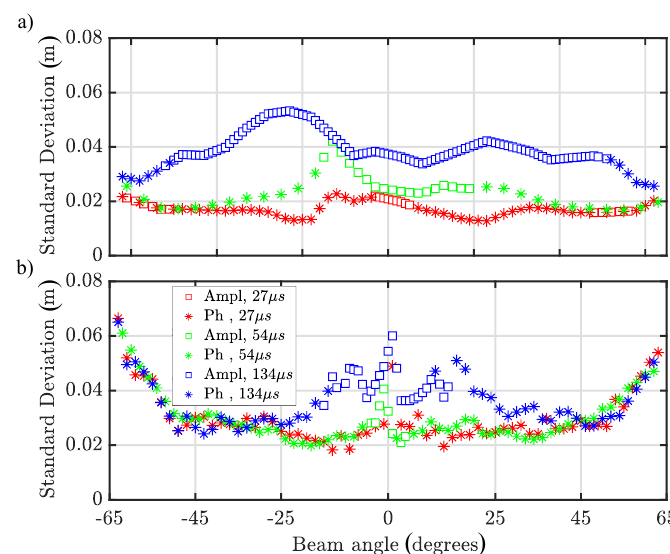
Figure 3. Standard deviation of the depth measurements for water depths of ( a ) 10m and ( b ) 30m, with a pulse length of 27µs (red), 54µs (green), and 134µs (blue). The transition from the amplitude (Ampl) to phase (Ph) detection is shown by changing the square marker to an